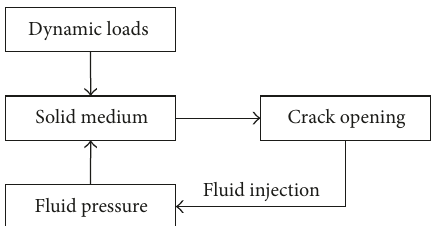
Figure 7: The coupling of the elasticity, fluid flow, and fracture